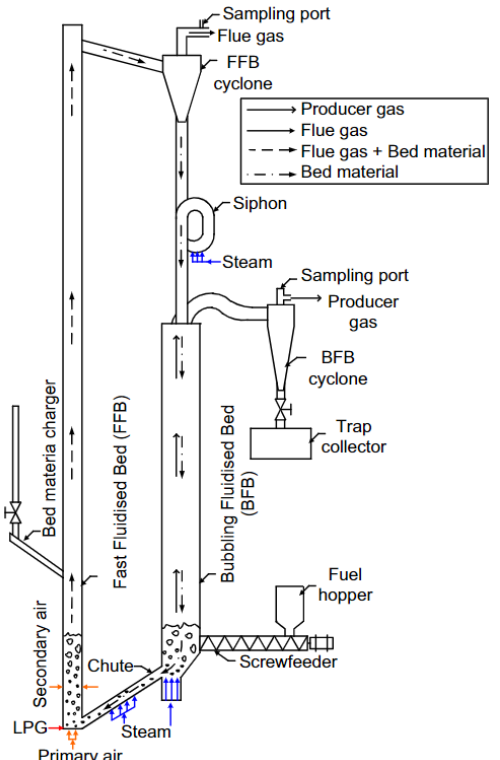
Figure 1. Schematic diagram of a dual fluidised-bed steam gasifier [57]. (Reprinted from Fuel, Vol. 102, W. Saw and S. Pang. The influence of calcite loading on producer gas composition and tar concentration of radiata pine pellets in a dual fluidised-bed steam gasifier, pp. 445–452, copyright (2012), with permission from Elsevier.)